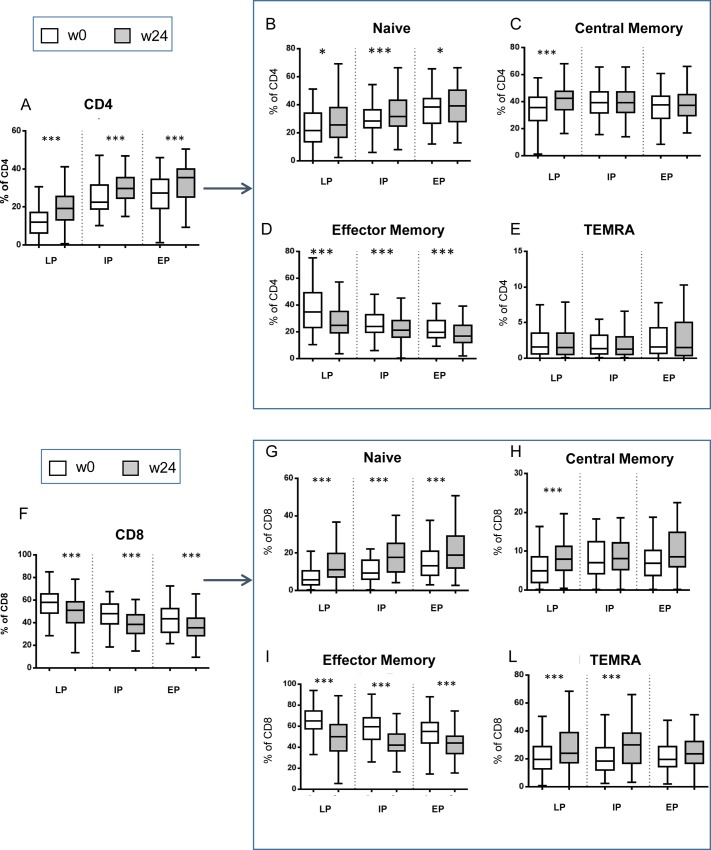
Impact of cART on CD4 and CD8 T cell differentiation profile.The differentiation profile of CD4 (A-E) and CD8 (F-L) T-cells was evaluated by flow cytometry before (wo, white bars) and after (w24, grey bars) therapy. The differentiation subsets of CD4 and CD8 T cells were defined as follow: B, G: Naive (CCR7+CD45RA+); C, H: Central Memory (CCR7+CD45RA-); D, I: Effector Memory (CCR7-CD45RA-); E, L: Terminally Differentiated (CCR7-CD45RA+). HIV patients were divided in three groups [late (LP), intermediate (IP) and early (EP) presenters] on the basis of their CD4 T cell counts at w0. Results are shown as Box and Whiskers graphs. The parametric Wilcoxon test was used, and p<0.05 was considered significant. *: p<0.05; ***: p<0.001.